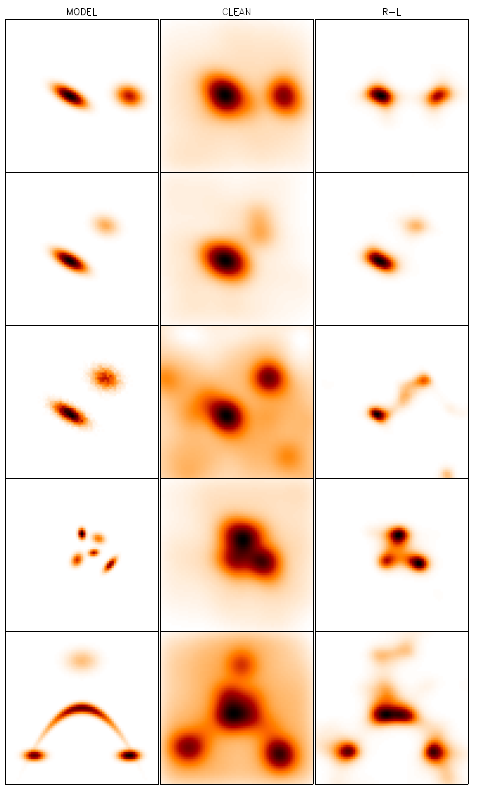
Figure 9. Simulated emission sources configurations (left column), and images reconstructed with the CLEAN-Vis (middle column), and RL (right column) algorithms. (see text for further details).